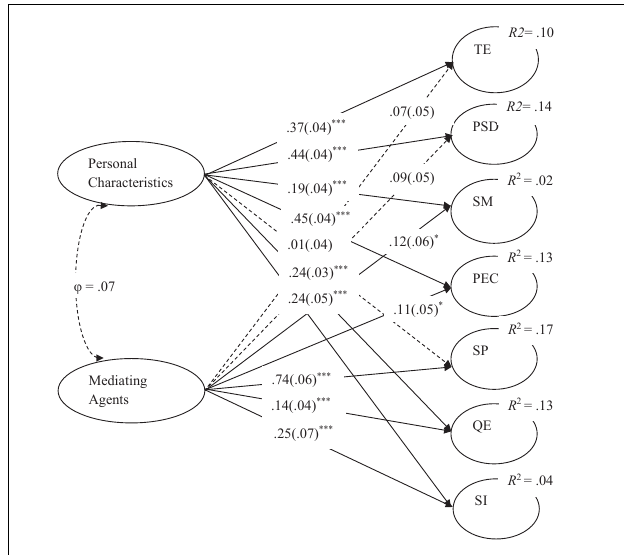
FIGURE 1 | Regression model of the effect of determinants of major choice on academic expectations with equal slopes across gender. Unstandardized robust maximum likelihood estimates for structural relationships ( N = 1,840). Refer to Table 1 for abbreviations. ϕ , disattenuated correlation. Standard errors are in parentheses. Dashed arrows, non-significant paths. ∗ p < 0.05. ∗∗∗ p <